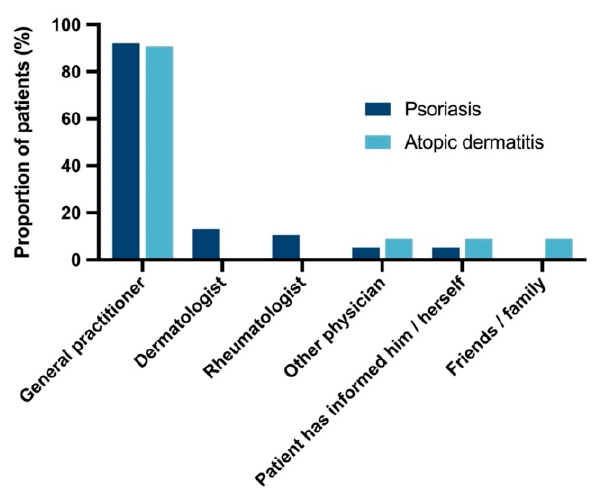
Figure 5. Recommendation of pneumococcal vaccination. The total number of patients according to recommendation of a pneumococcal vaccination by a health care provider or friends/family is depicted. The proportion of patients is based on the patients who had been vaccinated according to the questionnaire (n = 38 for PsO and n = 11 for AD). Multiple indications were permitted.